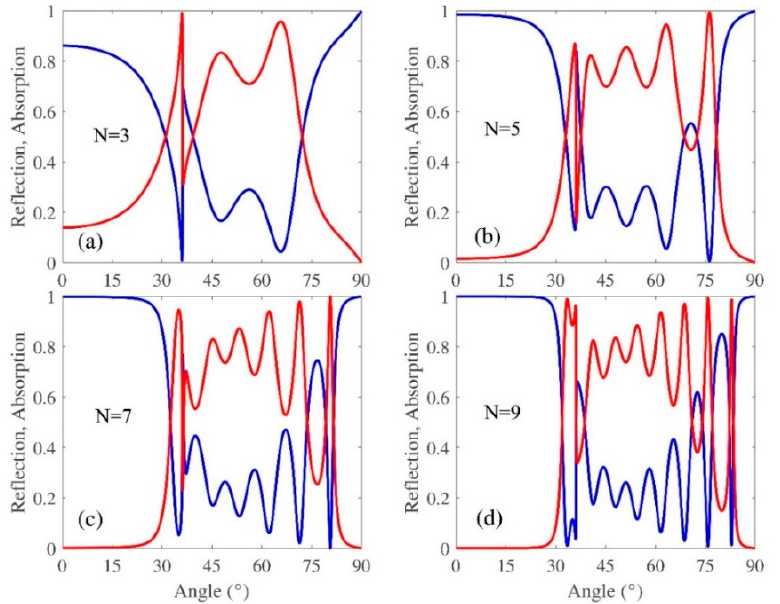
Figure 4. Absorption and reflection spectra of the DBR conjugated with the Bi 2 Se 3 layer at a different period number of TiO 2 /SiO 2 Bragg mirror under TM polarization. ( a ) N = 3, ( b ) N = 5, ( c ) N = 7 and ( d ) N = 9. The other parameters are the same as in Figure 3.